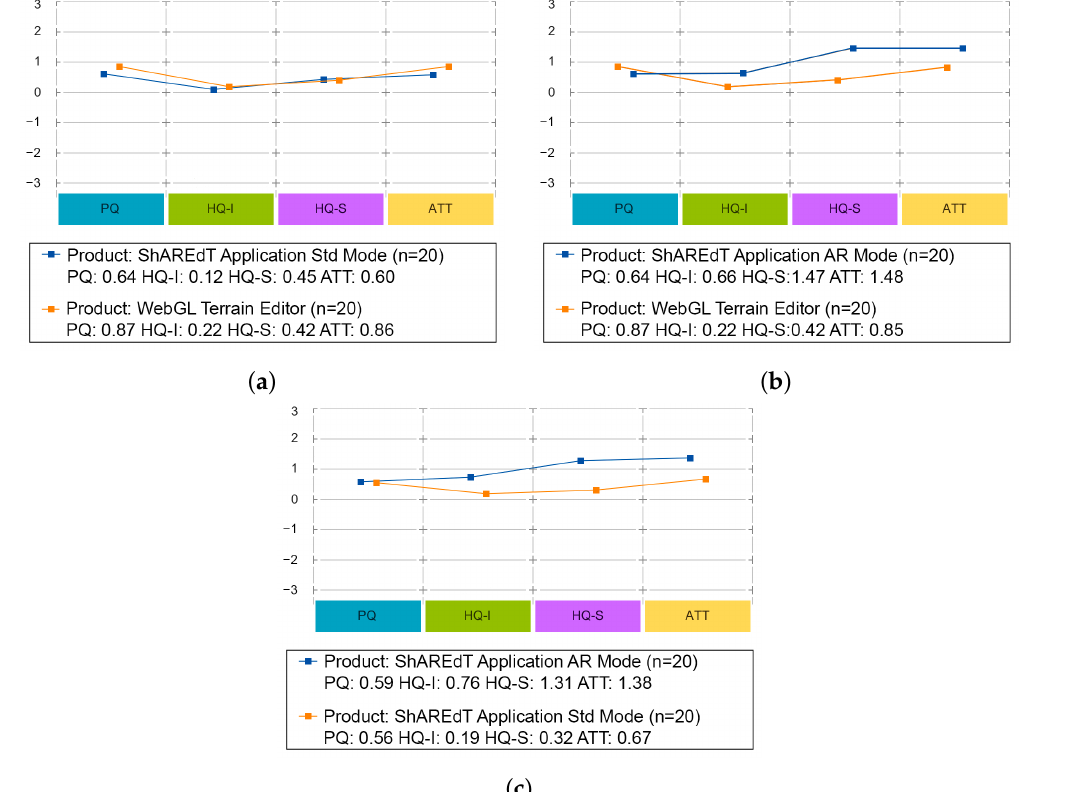
Figure 13. Dimensions charts for the three comparisons. ( a ) ShAREdT in standard mode vs. WebGL; ( b ) ShAREdT in AR mode vs. WebGL; ( c ) Standard mode vs. AR mode of